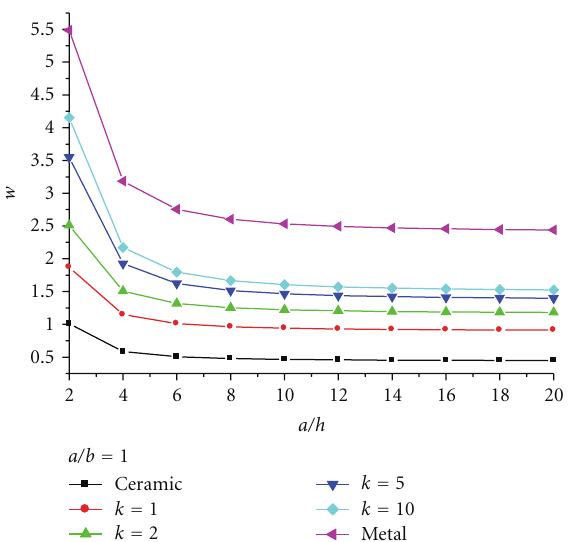
Figure 5: Variation of in-plane longitudinal stress ( σ xx ) through- the thickness of an FGM plate for di ff erent values of the side-to- thickness ratio.